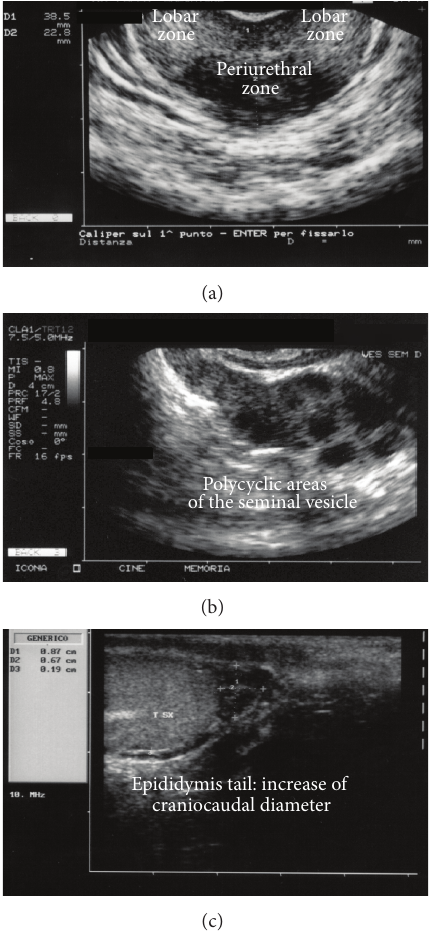
Figure 1: Examples of ultrasonographic suggestive images in patients with MAGI. (a) US subdivision of the prostate in peri- urethral and lobar regions. (b) Chronic vesiculitis. (c) Chronic epi-